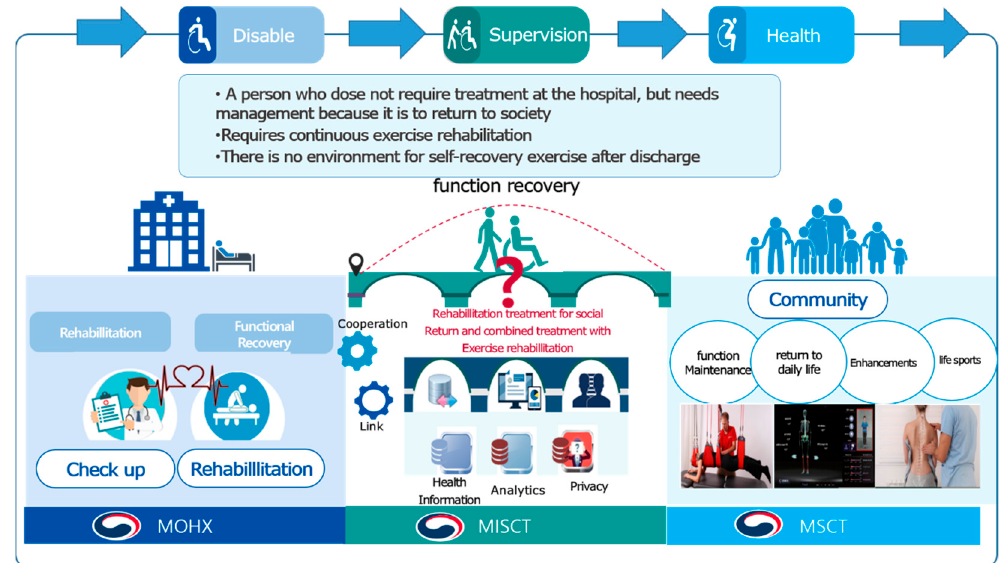
Figure 1. Inter-ministerial collaboration model. MOHW: Ministry of Health and Welfare, MISCT: Ministry of Science and ICT, MCST: Ministry of Culture, Sport and Tourism.